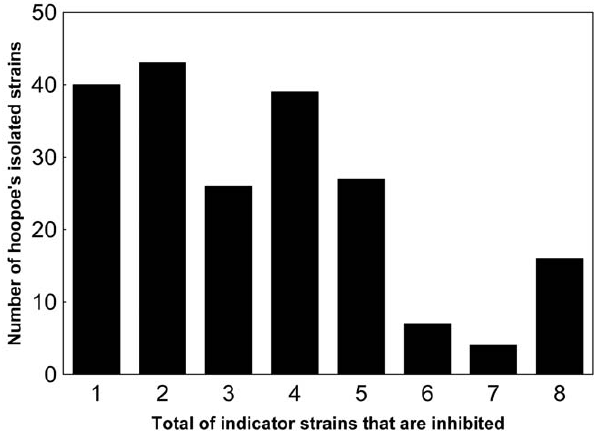
Figure 1. Antimicrobial activity rate. Variation in the number of symbiotic colonies isolated from hoopoe’s uropygial gland secretion that presented antagonistic activity against indicator bacteria.